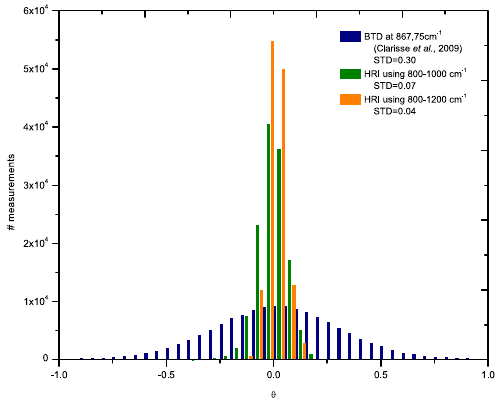
Fig. 8. Histogram of the 2 values of the new retrieval scheme (or- ange), for a smaller hyperspectral range (green) and for a bright- ness temperature difference detection method (Clarisse et al., 2009) (blue) for 15 August 2010 (morning overpass). The standard de- viation (STD) of 2 values associated with each approach shows the gain of sensitivity of this work using the HRI-based retrieval